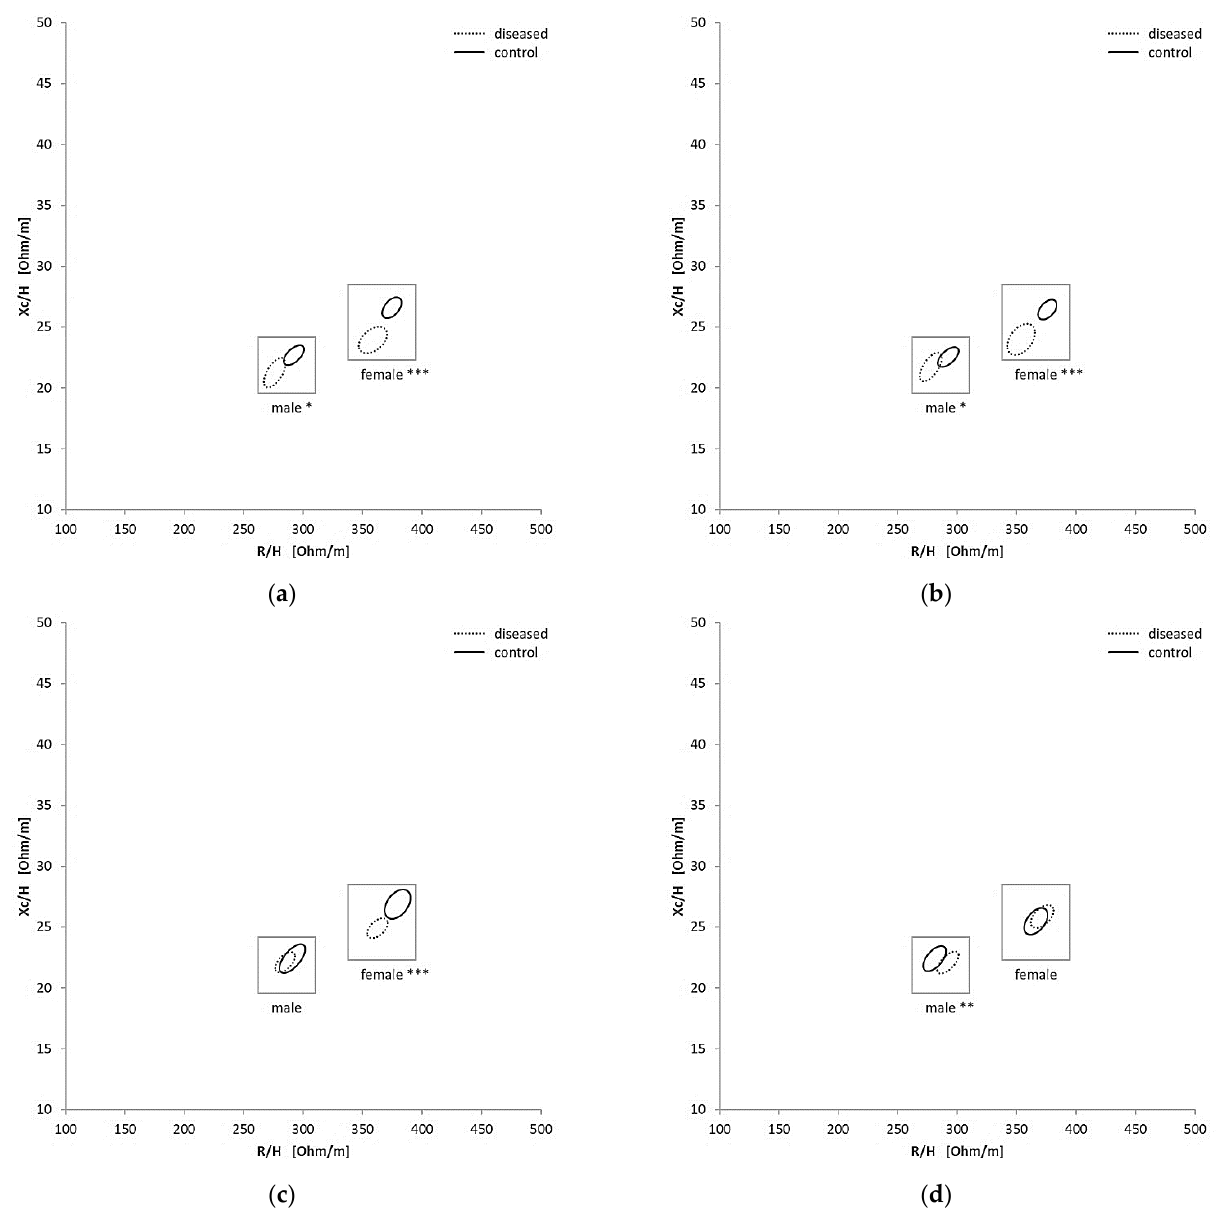
Figure 3. Confidence Ellipses in the RXc graphs for the different subgroups and each gender: renal ( a ), diuretic ( b ), cardiovascular ( c ) and dementia ( d ), * = p < 0.01, ** = p < 0.005, *** = p < 0.005.